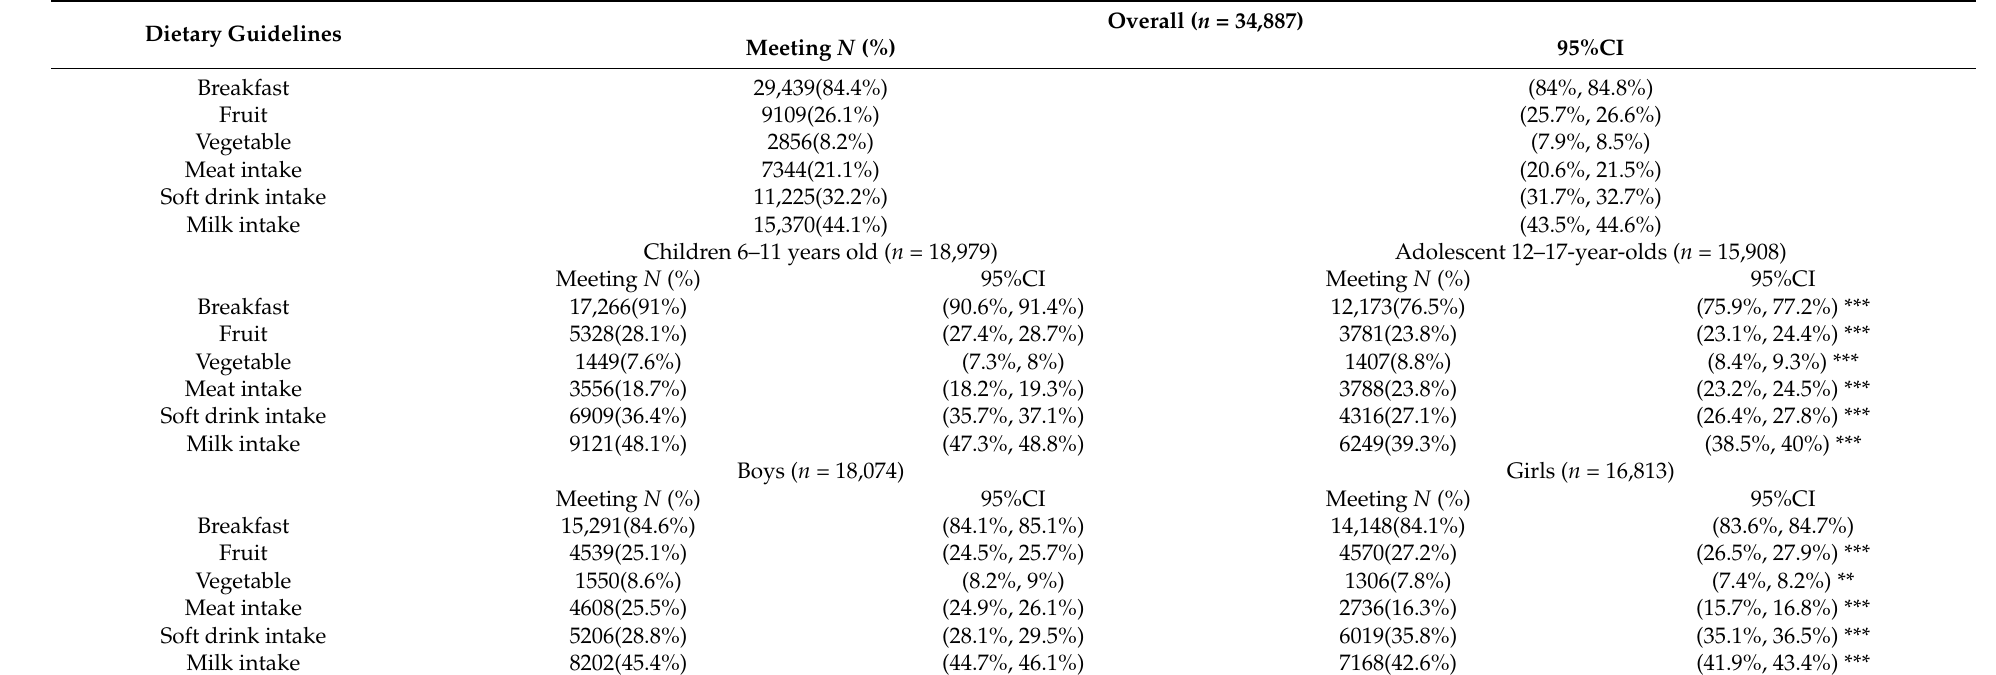
Table 3. Prevalence of meeting the various dietary